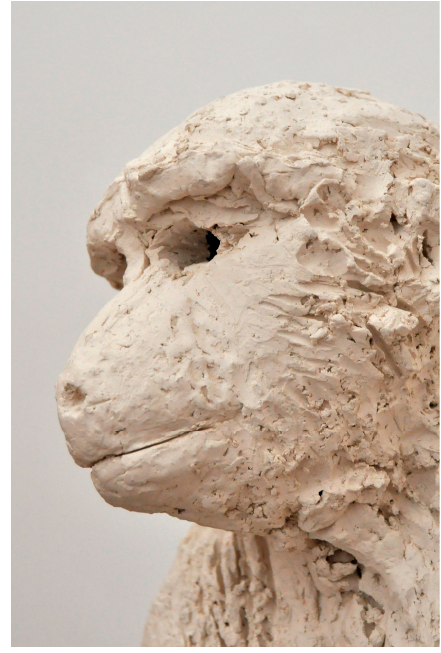
Figure 5. Monkey Business (2018), FILET, London. Ceramic, 50 × 36 × 25 cm.